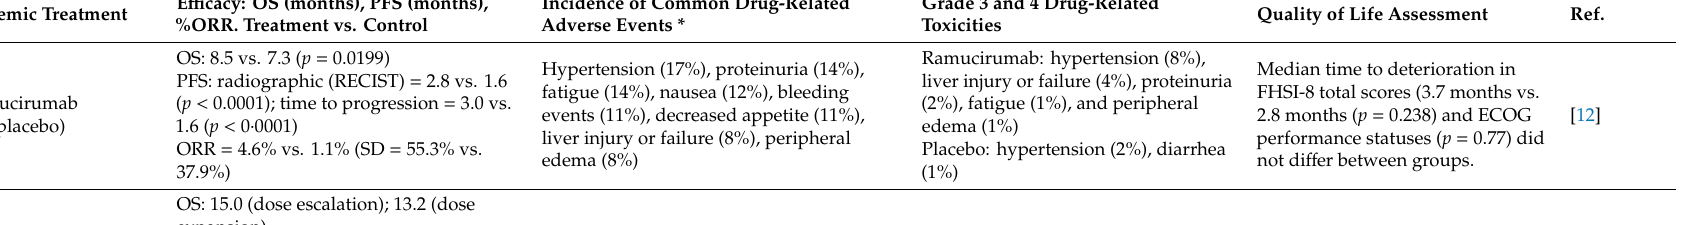
Incidence of Common Drug-Related Adverse Events *